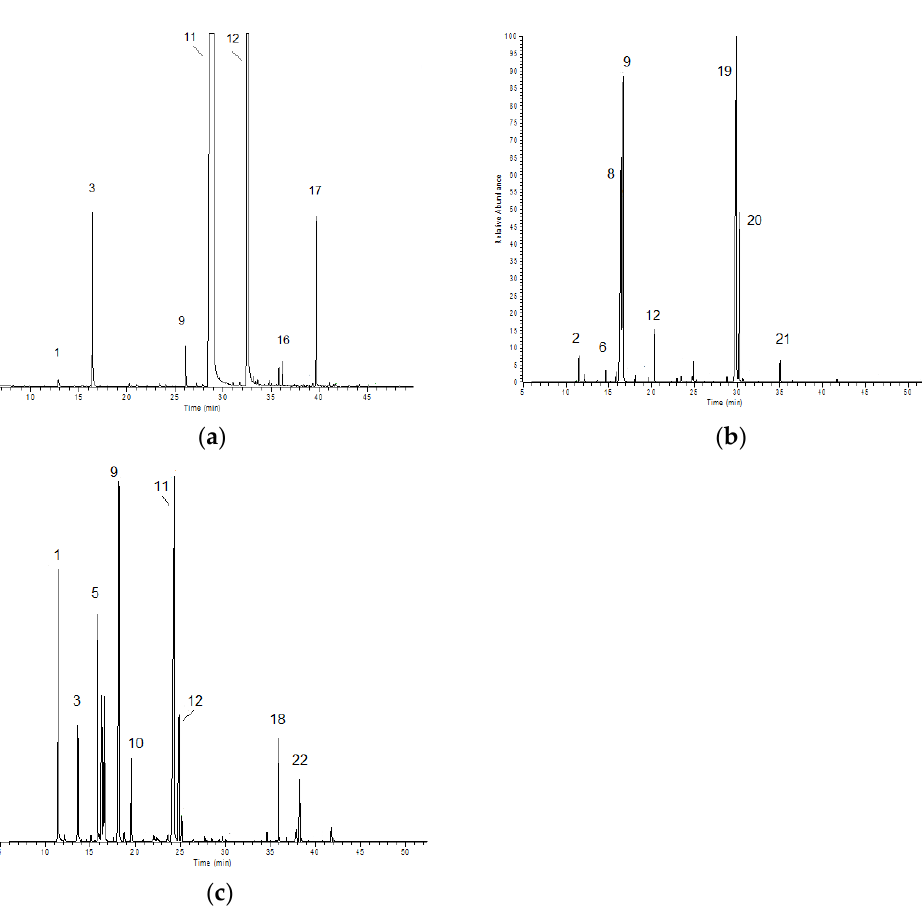
Figure 2. The GC-MS TIC chromatogram of commercial EOs: cinnamon ( a ), thyme ( b ), tea tree ( c ). Numbers refer to those reported in Tables S1 – S3. Table 1. Main chemical composition (>1.0%) of the three commercial EOs (cinnamon, thyme, tea tree) compared to L. angustifolia natural extract. Lavender EO was previously characterized [16].